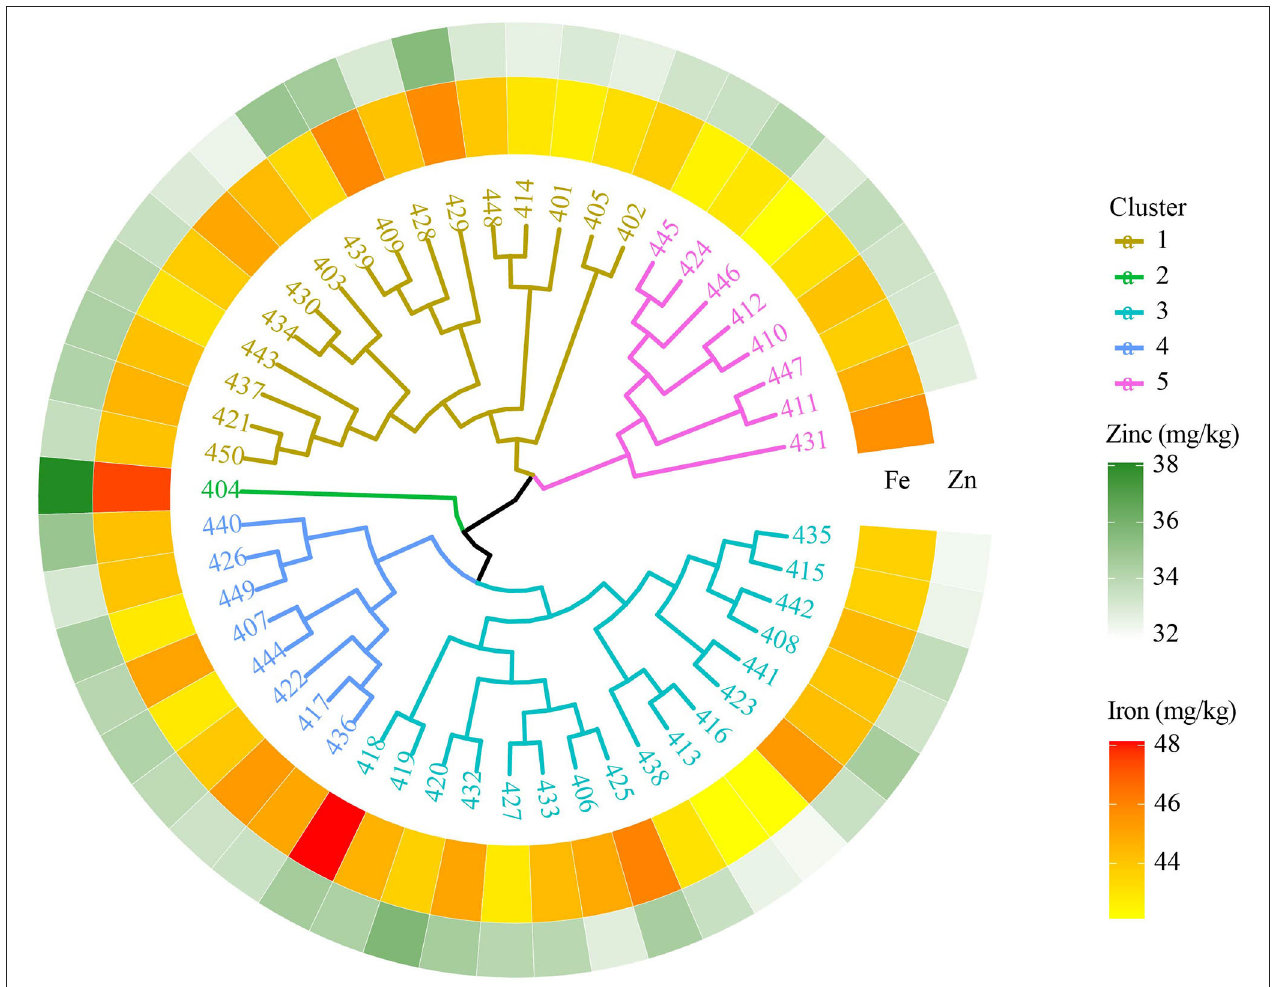
FIGURE 2 | Clustering of biofortified bread wheat genotypes from the 7th HPYT based on BLUP